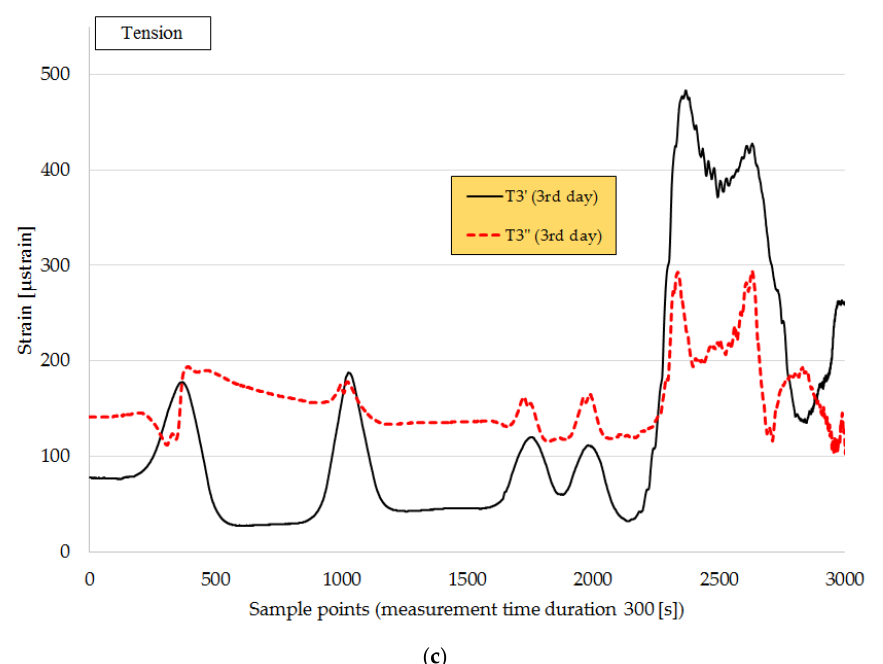
Figure 11. Strain values of sensors: ( a ) T1’ and T1’’, ( b ) T2’ and T2’’ at a temperature of 21 °C, and ( c ) T3’ and T3’’ at a temperature between 24 and 29 °C during the construction of the CyPaTs asphalt pavement on the third day.